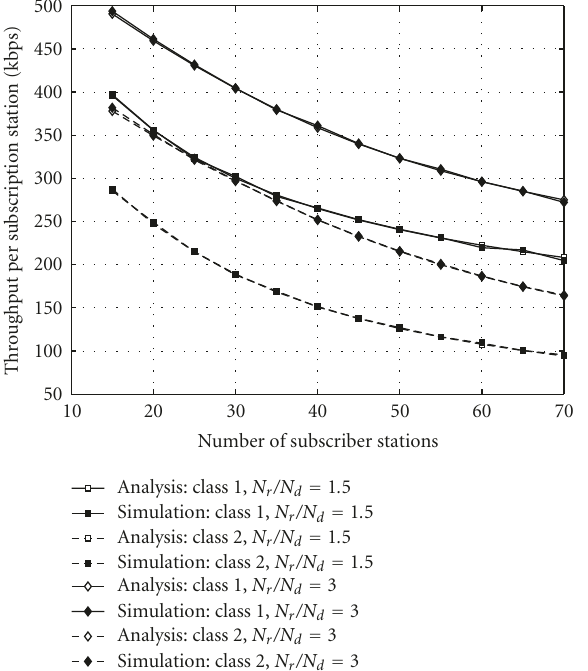
Figure 6: Delay of SS versus the number of SSs with equal bandwidth allocation priority and di ff erentiated channel access parameters: W 0,1 = N r , W 0,2 = 2 N r , W x ,1 = 2 4 W 0,1, and W x ,2 = 2 8 W 0,2